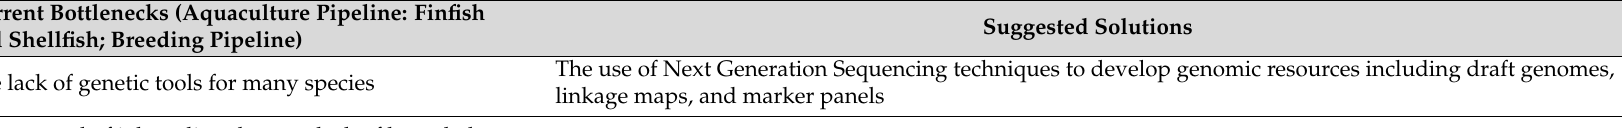
Table 2. List of major bottlenecks identified in the EMBRIC discovery